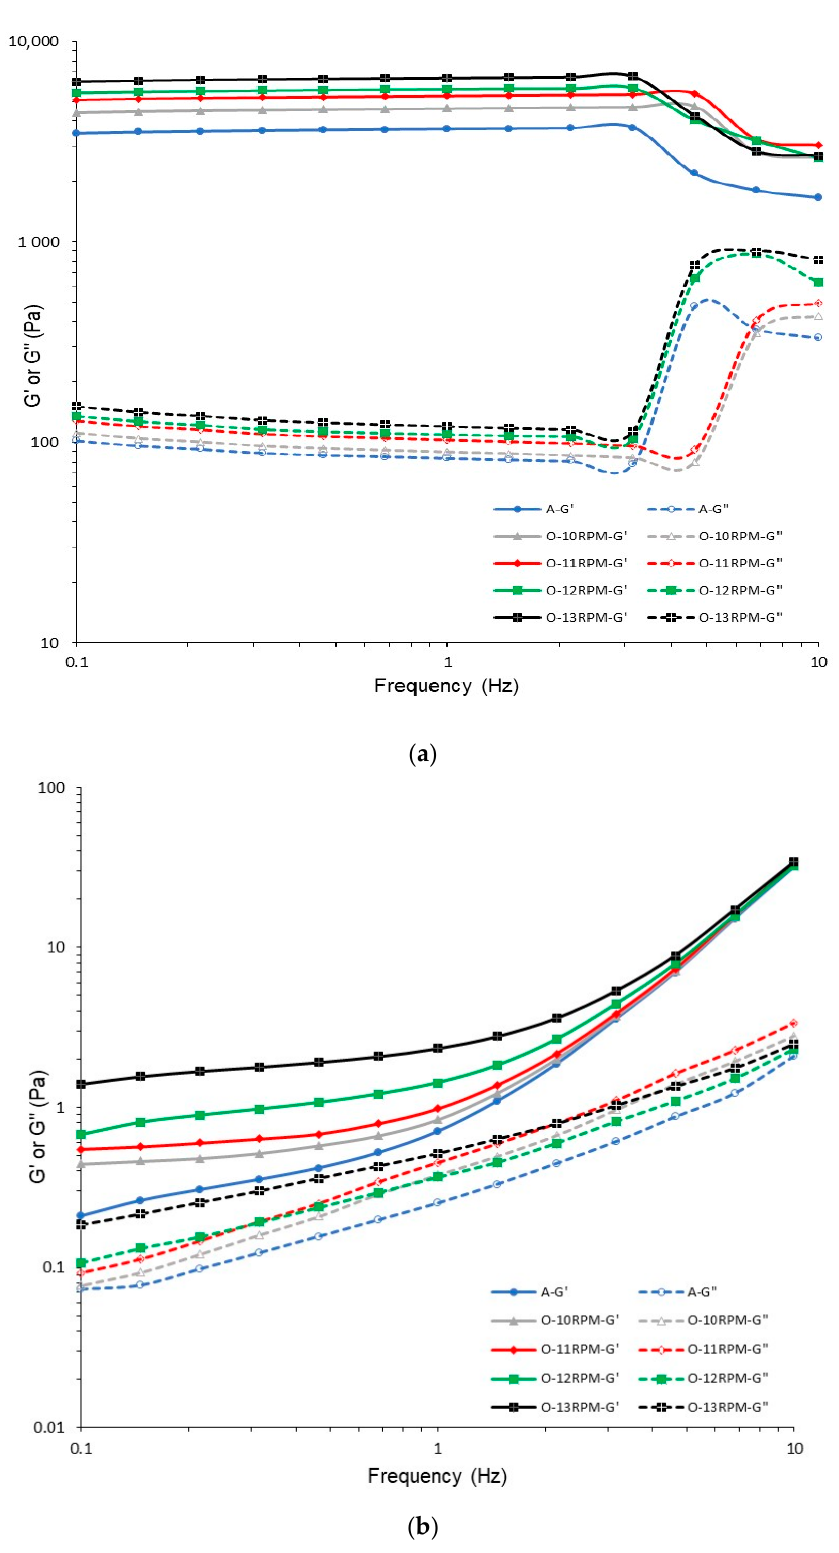
Figure 1. Frequency sweep curves of agar gel obtained with different mixing velocity at temperatures of 4 ( a ) and 50 °C ( b ).